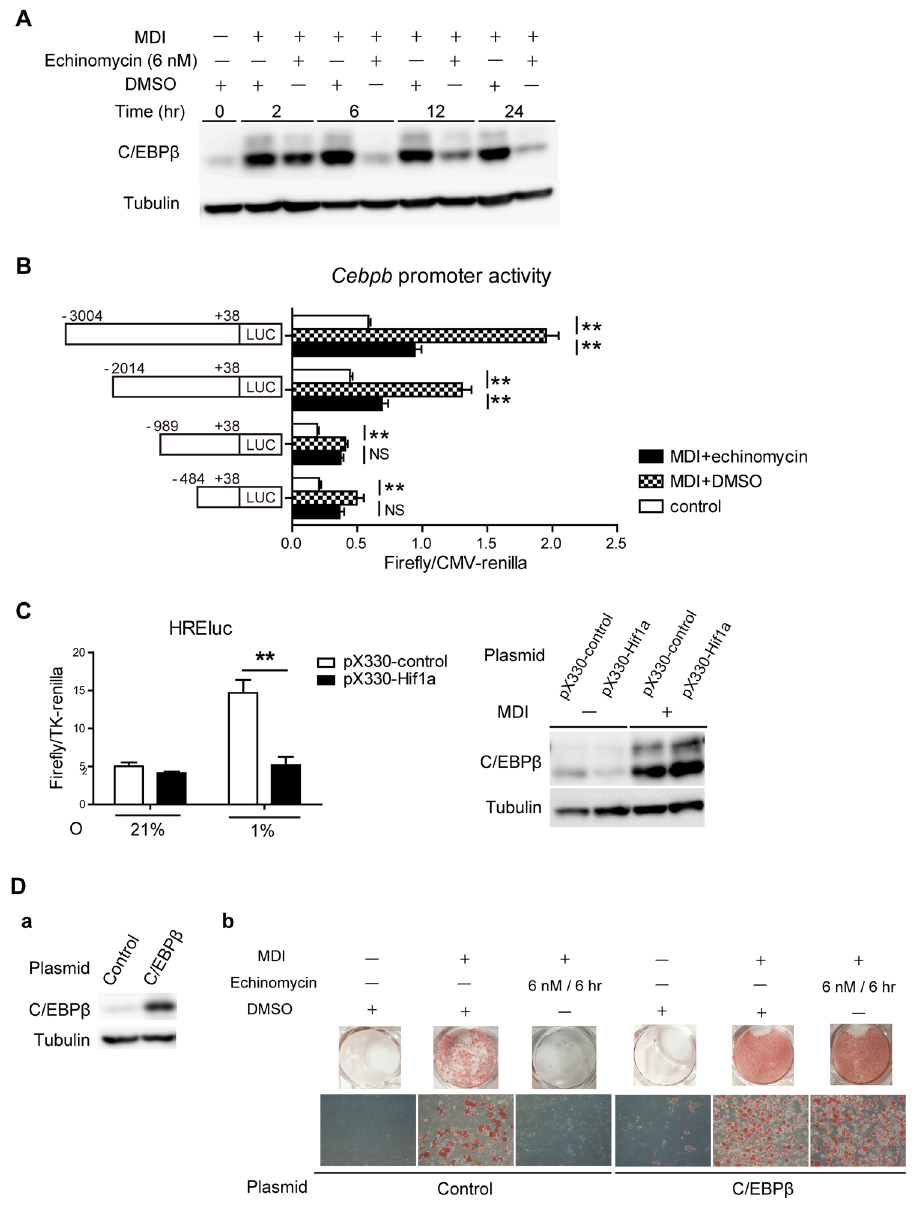
Figure 5. Echinomycin suppresses C/EBP β expression. ( A ) Immunoblot analysis of C/EBP β protein in 3T3-L1 cells was performed at 0, 2, 6, 12, and 24 hr after MDI + DMSO or MDI + echinomycin (6 nM) treatment. C/ EBP β protein induction under MDI treatment was inhibited by echinomycin. Full-length blots are presented in Supplementary Figure. ( B ) The activity of the mouse Cebpb promoter was measured 8 hr after the treatments. Luciferase activity was normalized to CMV-renilla. * P < 0.05, ** P < 0.01 vs. control (only-DMSO treatment), as determined by a two-way ANOVA with Bonferroni’s post-test. ( C ) ( Left panel ) HREluc reporter activity (firefly/TK-renilla) was measured at 16 hr after hypoxia treatment in stably expressing pX-330 against Hif1a . * * P < 0.01 vs. pX330-control, as determined by a two-way ANOVA with Boneferroni’s post-test. ( Right panel ) Immunoblot analysis of C/EBP β protein in 3T3-L1 cells that stably expresses pX330-control or pX330- Hif1a at 6 hr after MDI treatment. Knockout of Hif1a by pX330-Hif1a did not influence the induction of C/ EBP β by MDI treatment. Full-length blots are presented in Supplementary Figure. ( D ) (a) Mouse C/EBP β stable overexpression 3T3-L1 clones were generated using a retroviral system and its C/EBP β expression was confirmed by immunoblot analysis. Full-length blots are presented in Supplementary Figure. (b) Stable 3T3-L1 clones against control or C/EBP β were treated with MDI + DMSO or MDI + echinomycin. Oil red O staining was performed at 8 day after induction. C/EBP β overexpression restored adipogenesis under echinomycin treatment. For all panels, the data are the mean ± SEM or representative of at least three